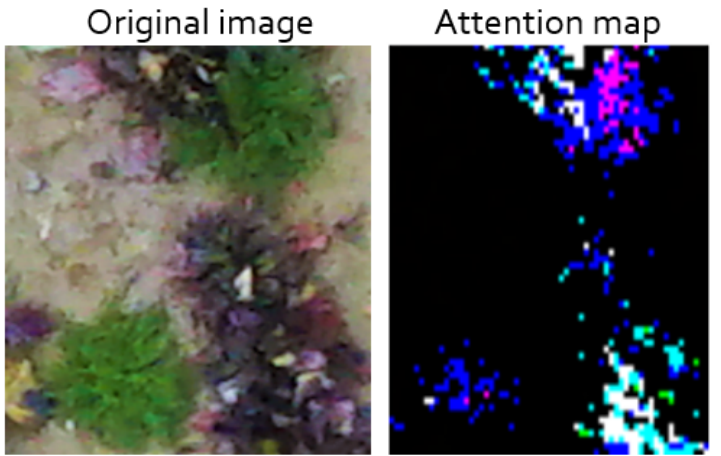
Figure 5. Attention mechanism on an image patch ( left ) containing weeds (in green) and beet plant (in red). With the original image on the left and the attention map ( right ) obtained with ViT-B16 model. The attention map shows the model’s attention on the different plants: with a dark blue and purple colour pixel representing the attention on the weeds and a light blue colour pixel representing the beet